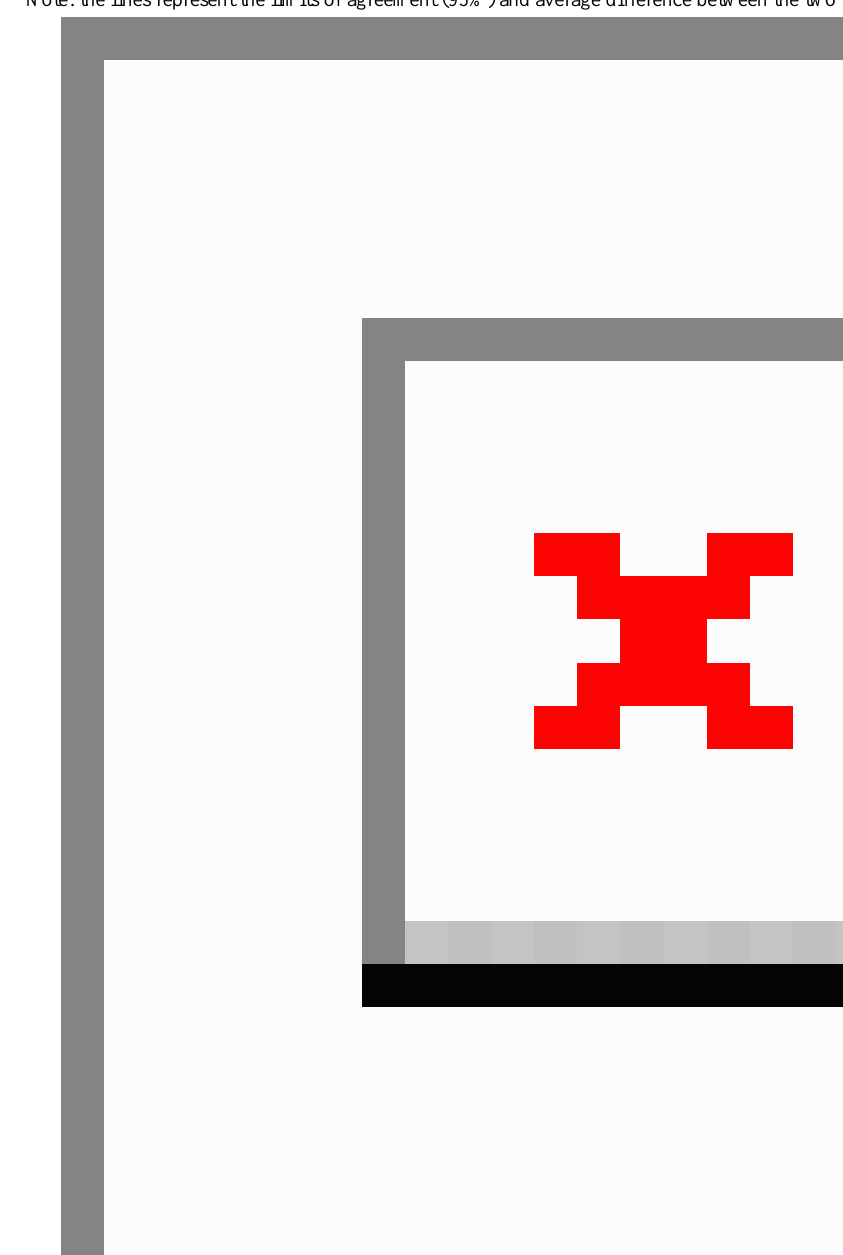
Figure 4. Bland-Altman plot of natural log transformed score showing the difference between follow-up IPAQ and MAAS, plotted against the mean. Note: the lines represent the limits of agreement (95%) and average difference between the two